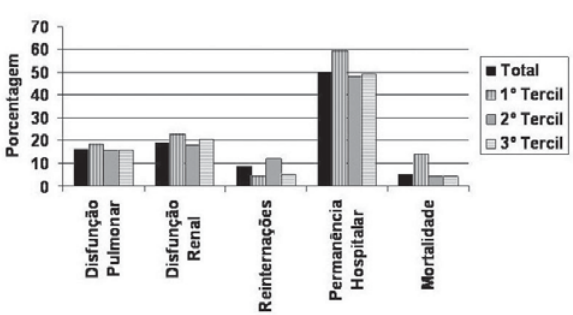
Fig. 1 - Prevalência das complicações pós-operatórias por categoria de IMC. IMC – Índice de Massa Corpórea